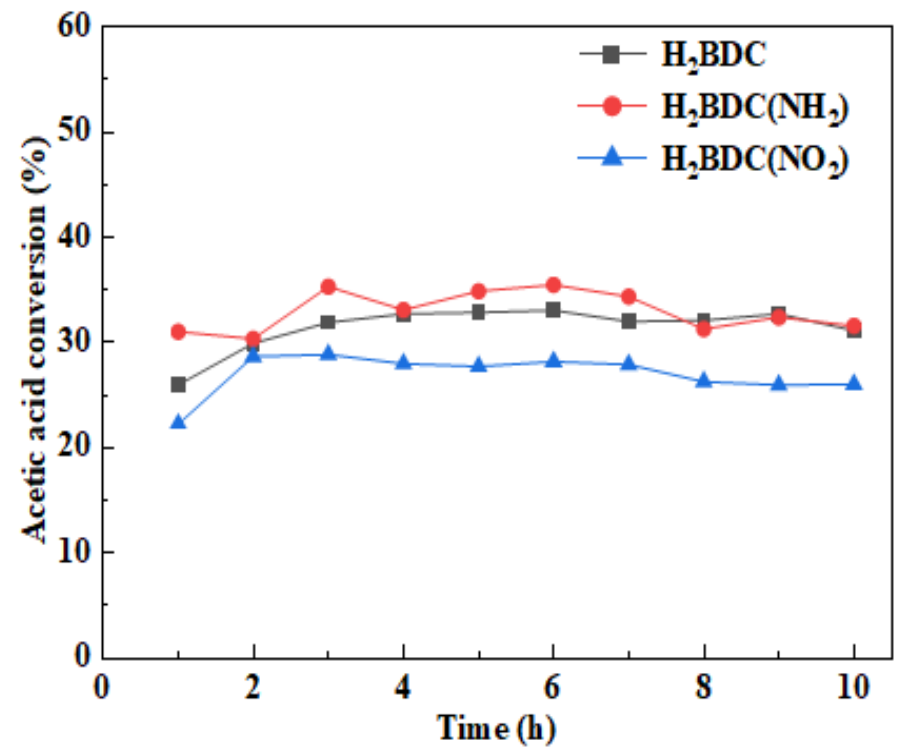
Figure 10. Acetic acid conversion of catalysts prepared by precursors prepared with different organic preparation systems at 450 °C.